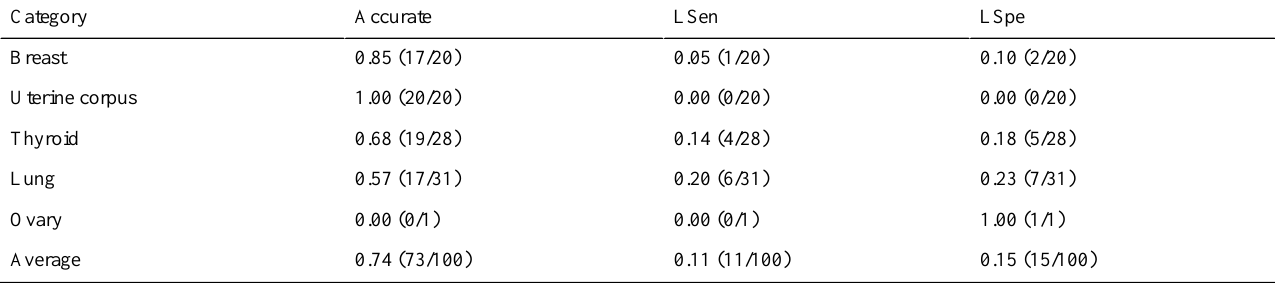
Table 5. Accuracy of diagnosis based on sWSI VS by pathologist B. Results are presented as ratios between 0.00 and 1.00. LSpeLSenAccurateCategory